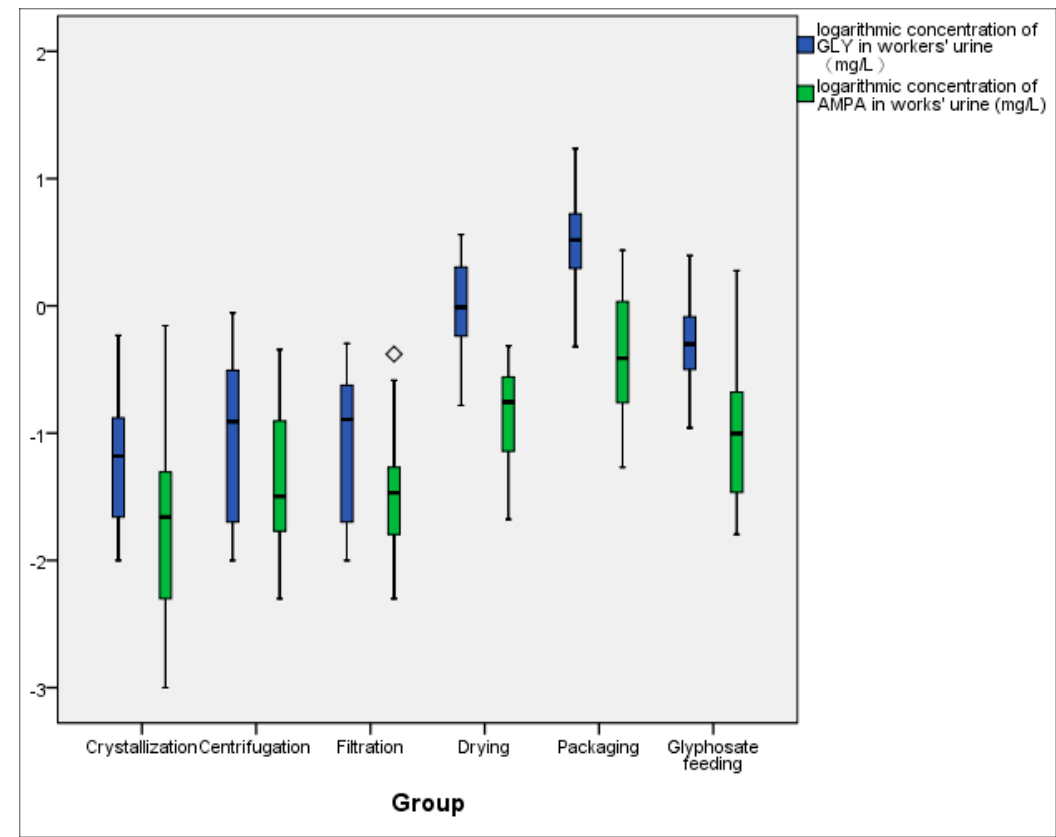
Figure 2. Distribution of urinary glyphosate and AMPA according to the different occupational groups.